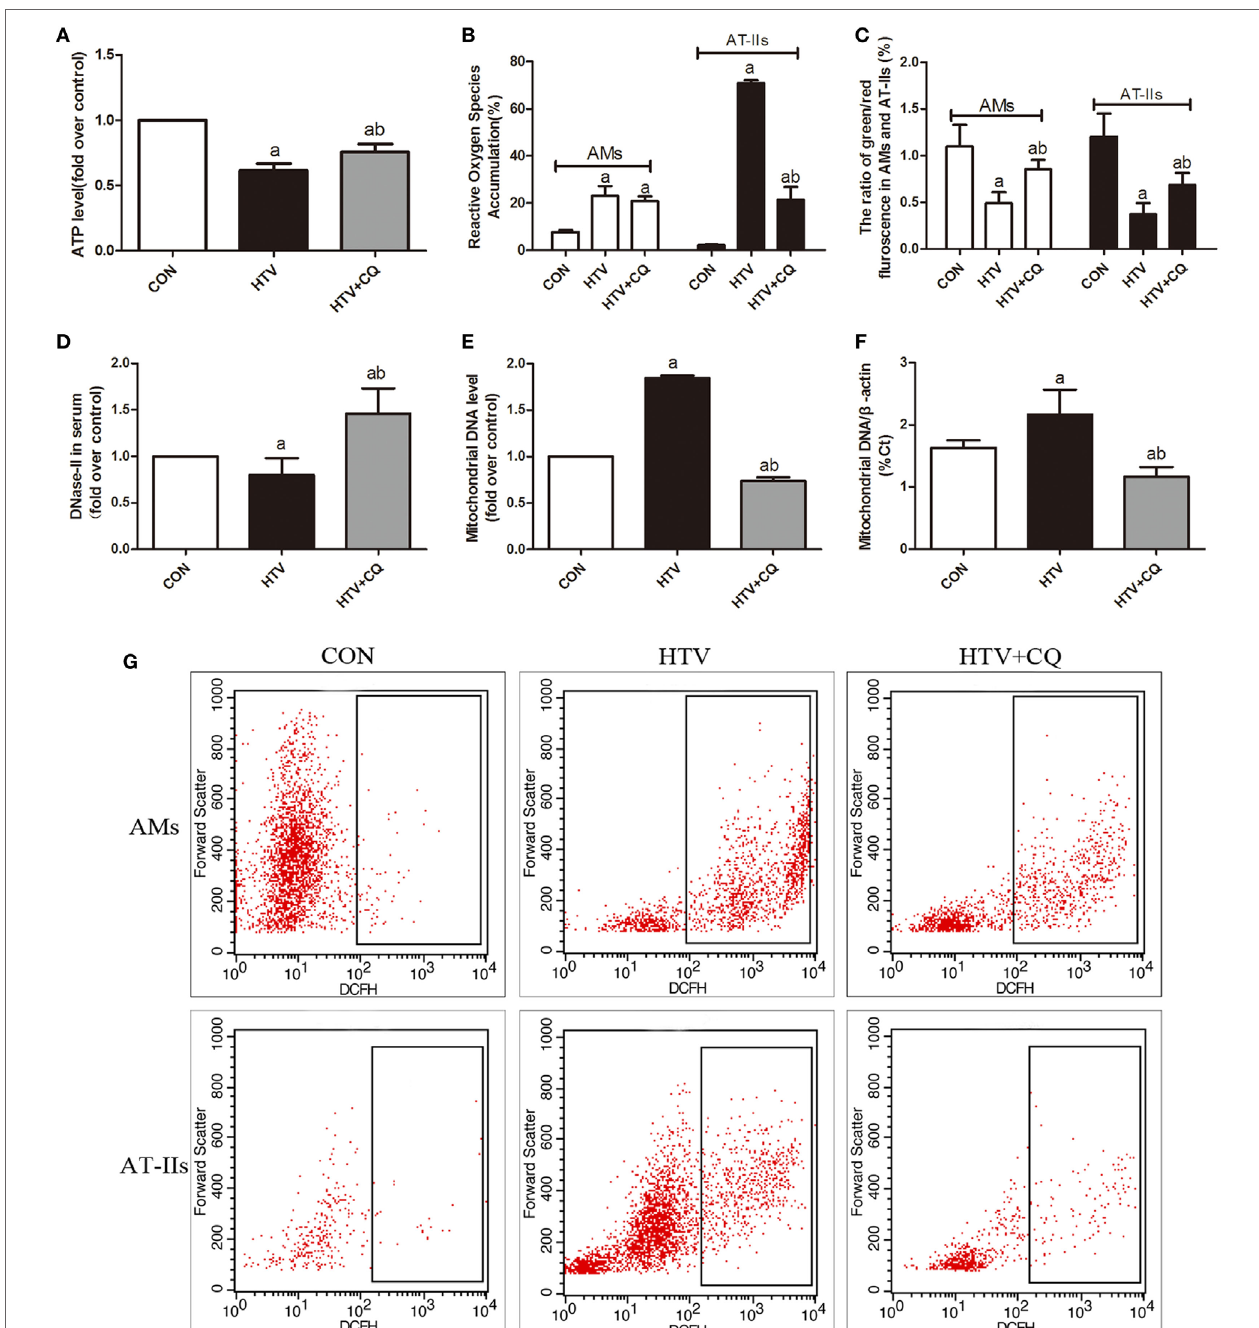
FigUre 3 | Mechanical ventilation with high tidal volume (HTV) favors the damage of mitochondrial and the release of mitochondrial DNA (mtDNA). (a) Levels of ATP. (B) Levels of reactive oxygen species (ROS) in alveolar macrophages (AMs) and AT-IIs. (c) Levels of Δψ m were noted by the decreased ratio of green (JC-1 monomer for low Δψ m)/red (J-aggregates for high Δψ m) fluorescence in AMs and AT-IIs. (D) Levels of DNase-II in plasma. (e) Levels of isolated mtDNA (fold over control). (F) Relative levels of mtDNA by measurement of the β -actin gene. (g) The flow cytometry analysis of ROS. Both of these experiments were in triplicate. a P < 0.05 vs. CON; b P < 0.05 vs. HTV